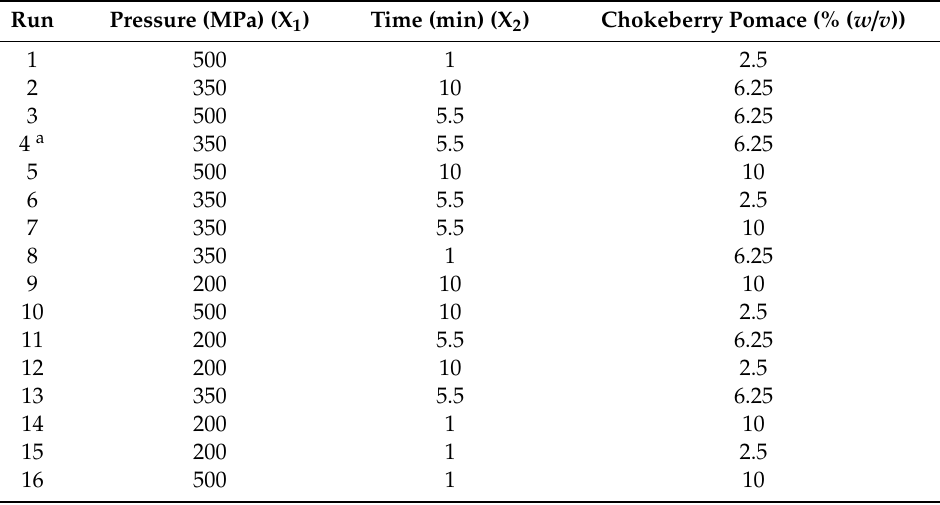
Table 1. Experimental design matrix for studies